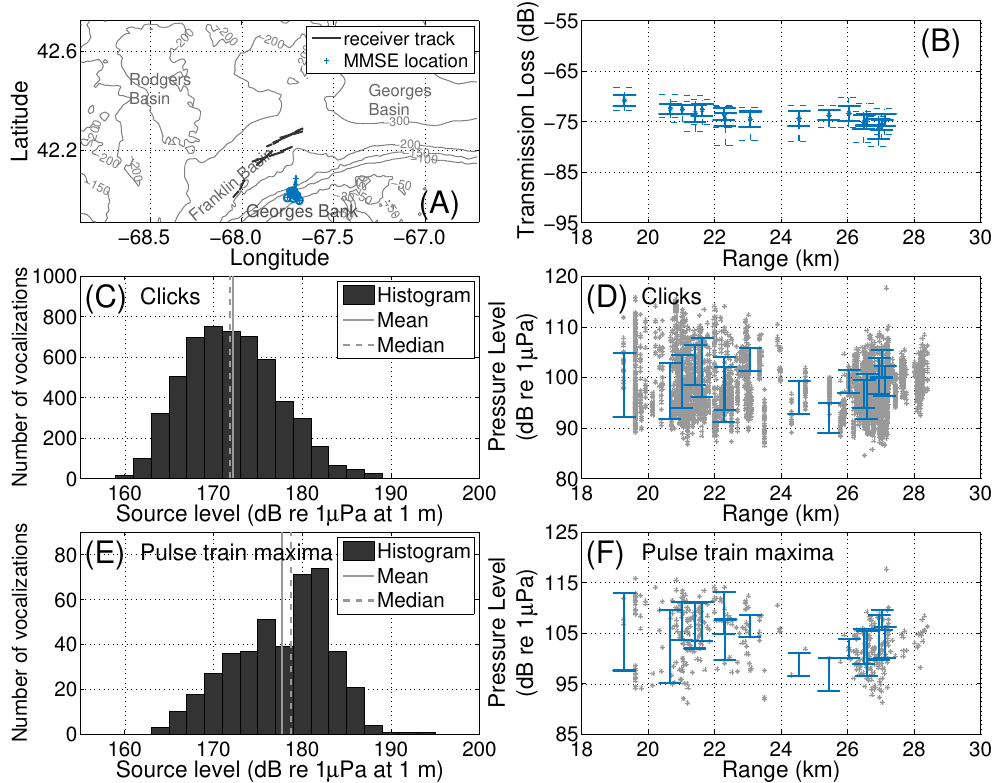
S ou r c e l e v e l ( d B r e 1 µ P a a t 1 m ) Figure 6. ( A ) The MMSE estimated center locations of sequences of minke whale pulse train vocalizations from 16 distinct bearing-time trajectories consisting of a total of 431 pulse trains and 5390 clicks; ( B ) Corresponding one-way broadband transmission losses from the MMSE estimated minke whale vocalization sequence center locations to the POAWRS receiver array center. The transmission loss standard deviations (solid bar), minimum and maximum values (dotted bar) are calculated assuming the whales are located at each potential depth from the sea surface to near the seafloor; ( C ) The distribution of the individual minke whale click vocalization source level estimated from bandpass-filtered beamformed signals has a mean of 172.2 ± 5.3 dB re 1 µ Pa at 1 m; ( D ) The corresponding received click pressure levels are plotted as a function of distances from instantaneous MAT location estimates to the receiver array center. The blue bars represent one standard deviation in the pressure levels estimation; ( E ) The distribution of the maximum minke whale vocalization source level obtained from the maxima of the click source level in each pulse train has a mean of 177.7 ± 5.4 dB re 1 µ Pa at 1 m; ( F ) The maximum beamformed received pressure levels of each minke whale pulse train used to derive the distribution in ( E ). The blue bars in ( D , F ) represent one standard deviation in the pressure levels for each bearing-time